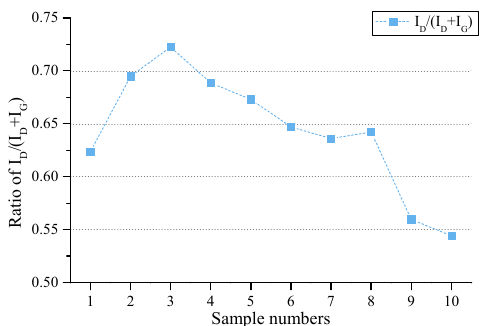
Figure 11. Distribution of I D /(I D + I G ) ratios.